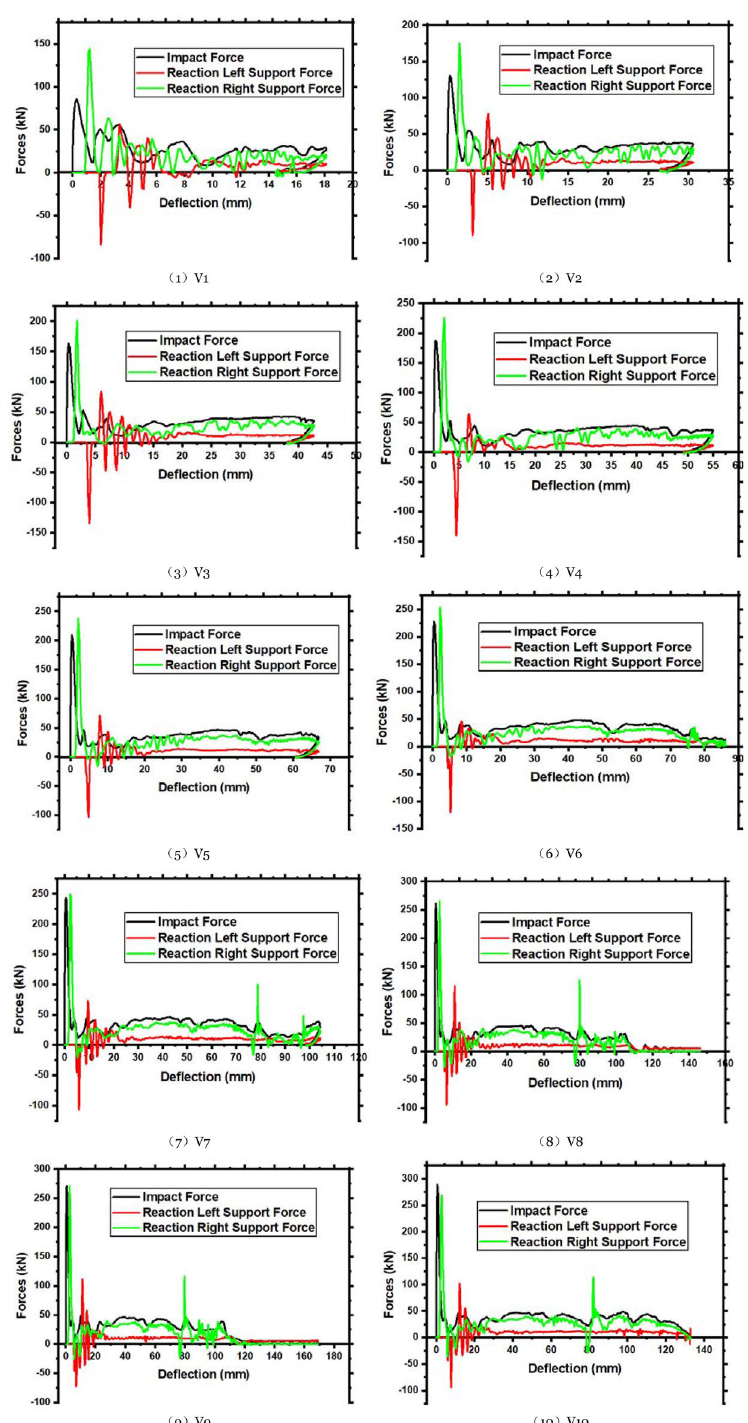
Figure 18. Force–deflection curve of the members under different impact